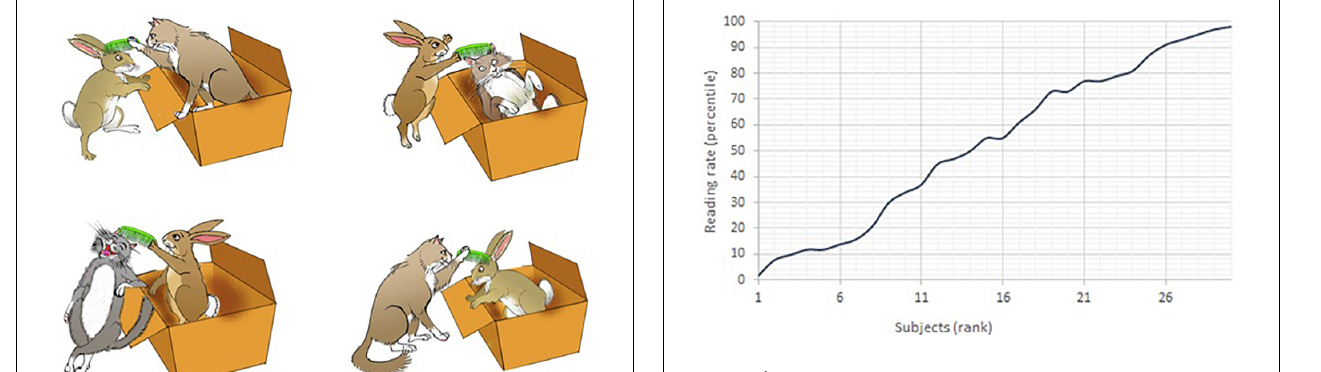
FIGURE 2 | Line-graph of reading rate – rank.